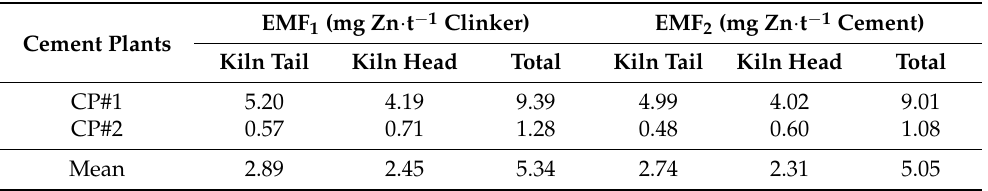
Table 2. Atmospheric EMFs of Zn for the two